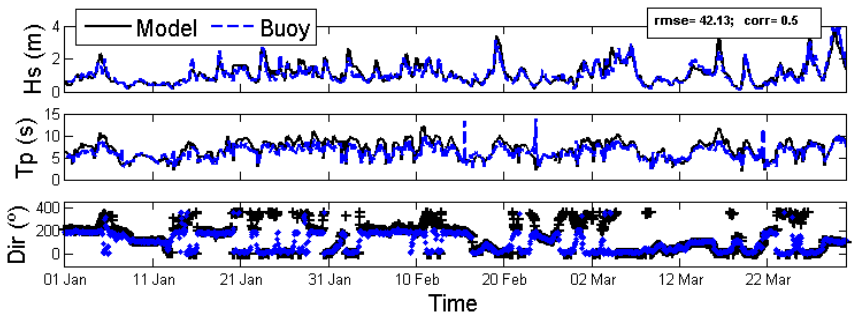
Figure 6. Capdepera buoy observations (blue) and hindcasted SIMAR (black) time series of H s , T p and wave direction. RMSE and correlation are quoted for the wave direction (the values for H s and T p are quoted in Fig.